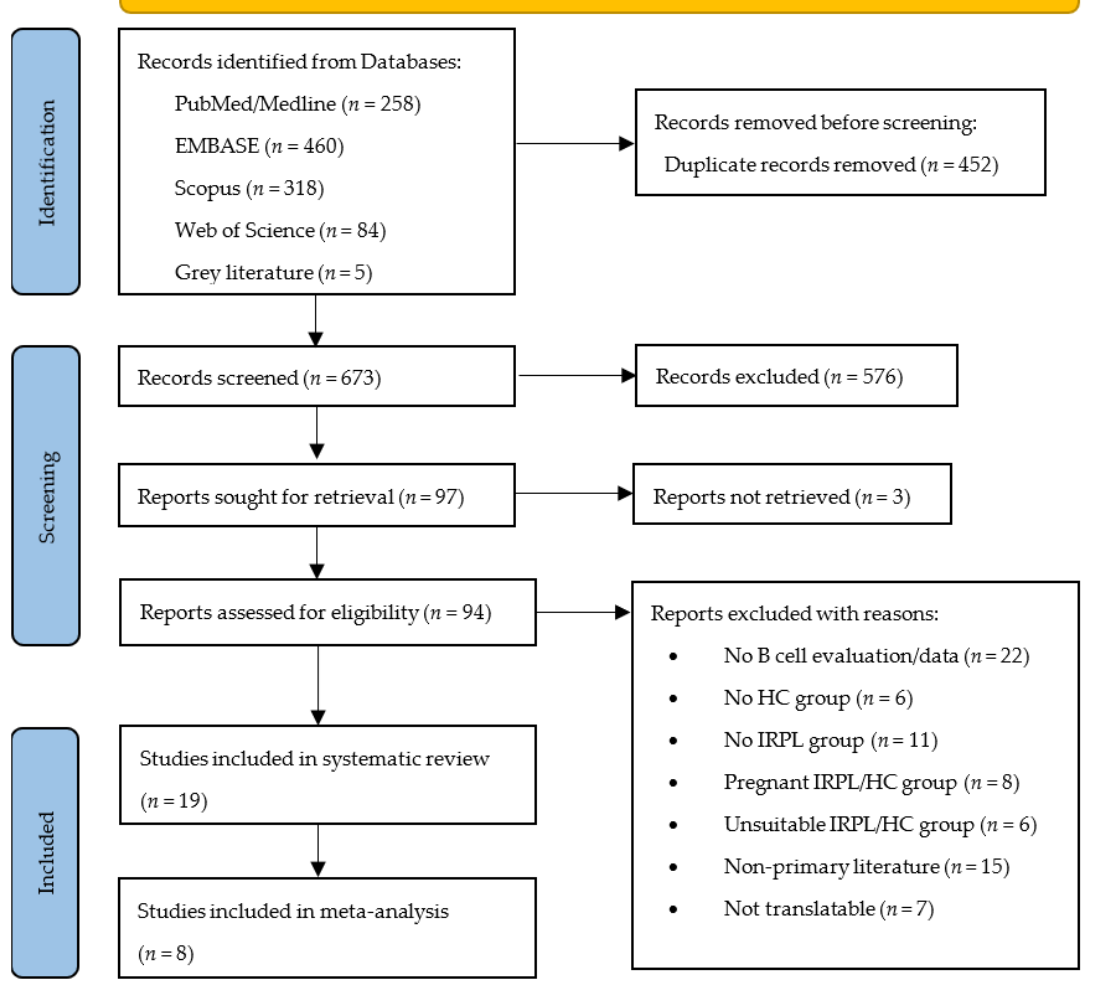
Figure 1. PRISMA 2020 flow diagram. PRISMA, Preferred Reporting Items for Systematic Reviews and Meta-analyses; HC, healthy control; IRPL, idiopathic recurrent pregnancy loss.